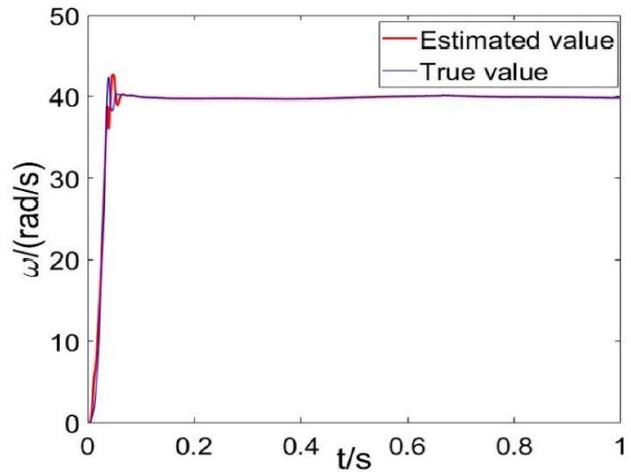
Figure 6. The estimated value of motor speed.